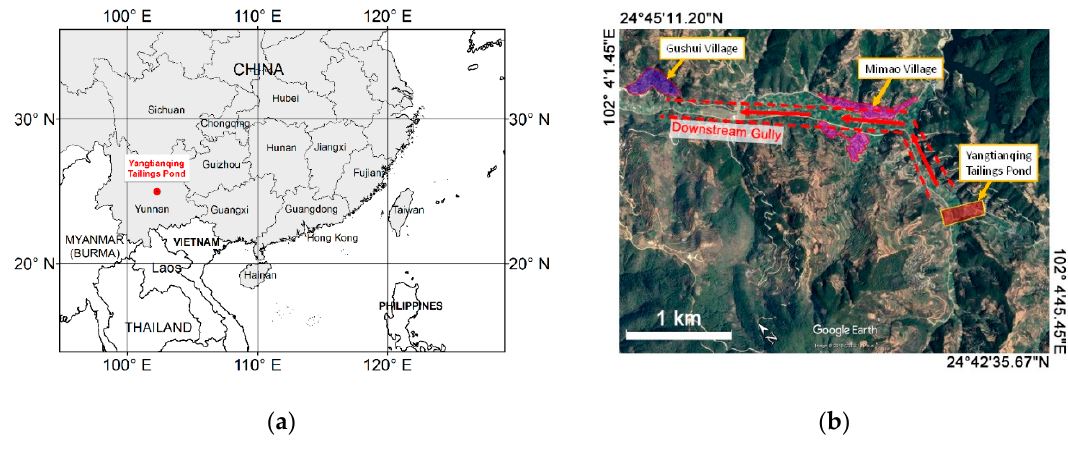
Figure 1. ( a ) Locations of Yunnan Province and the Yangtianqing tailings pond; ( b ) Locations of the Yangtianqing tailings pond and downstream villages (Google Earth).